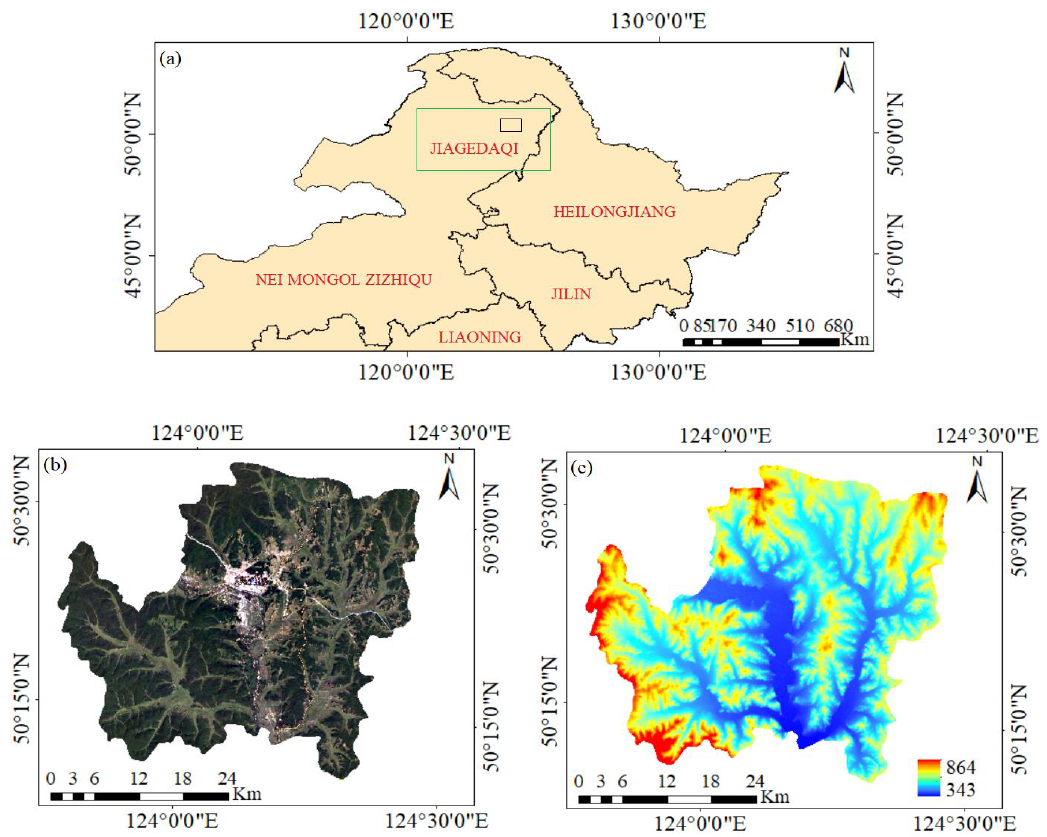
Figure 1. Map showing the study area: ( a ) location of the study area on the map of China, the black box is the location of the study area, the green box is to highlight the study area; source: (https://zwfw.ch.mnr.gov.cn/index, accessed on 3 August 2021); ( b ) image map of the study area; ( c ) DEM. source: (http://dwtkns.com/srtm30m/, accessed on 14 March 2021).